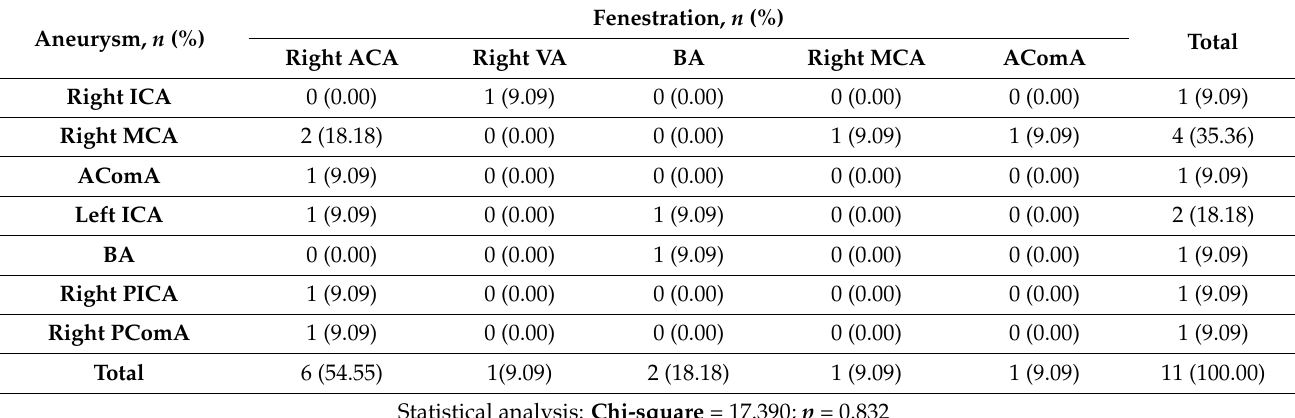
Table 3. Occurrence of aneurysms in patients with various types of vascular fenestration.